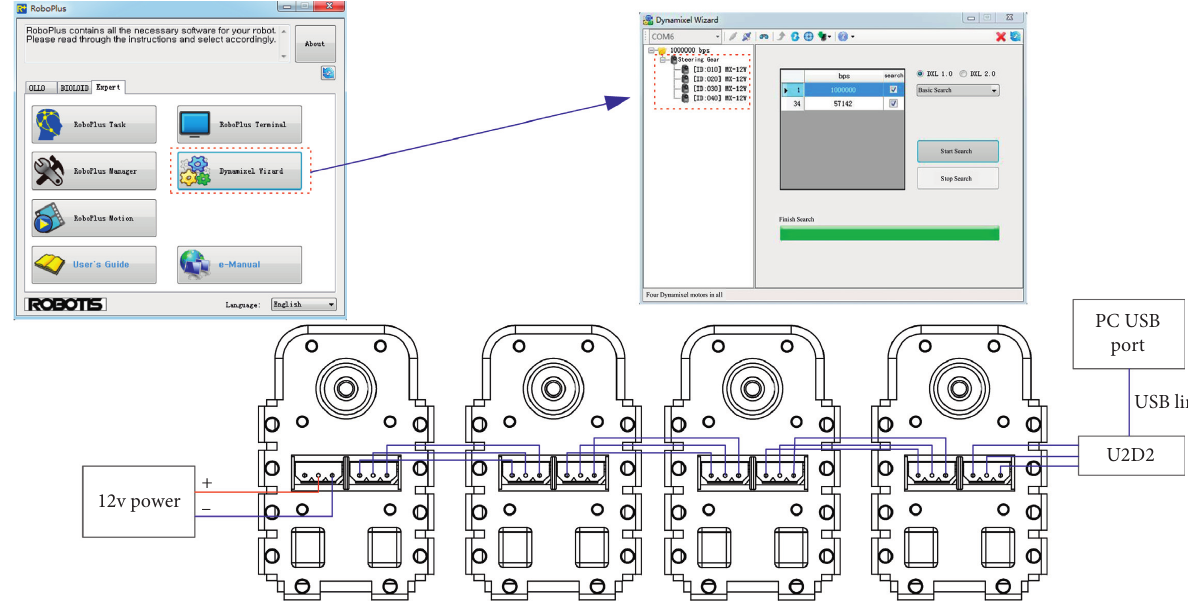
Figure 6: The schematic diagram of Dynamixel actuator